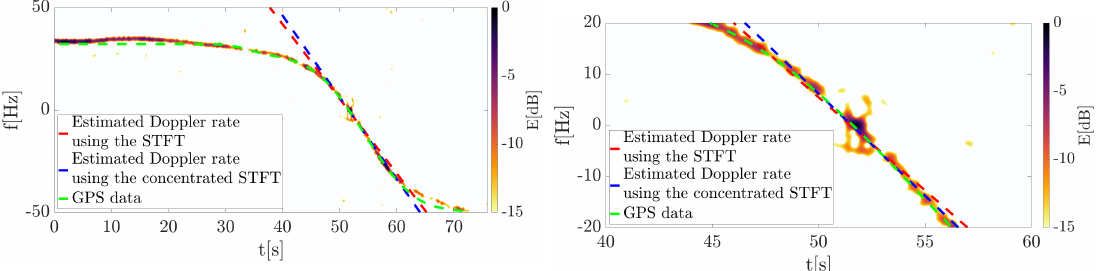
Figure 9. Results of the Hough transform obtained for the two methods investigated - the classical and the reassigned STFT.